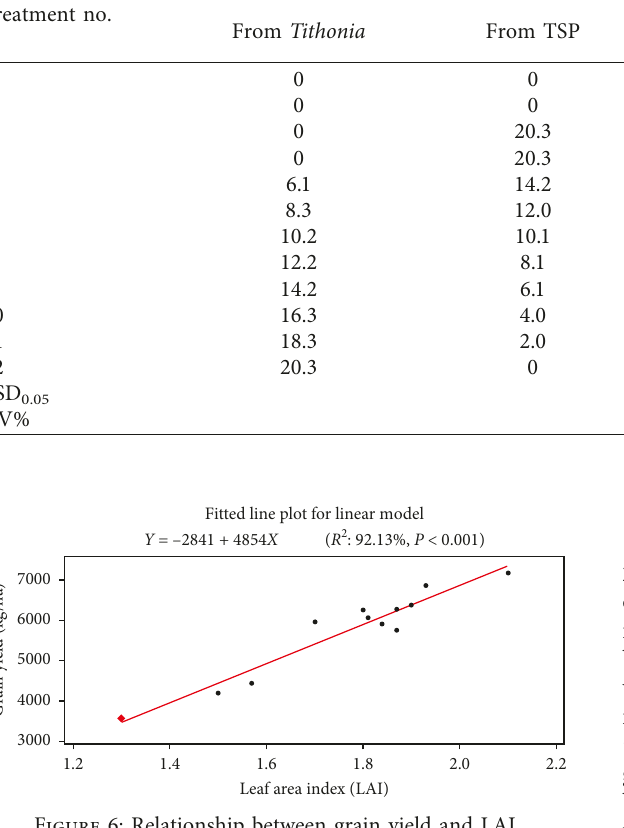
Table 6: Leaf area measurements of maize as affected by the combined application of Tithonia biomass and phosphorus fertilizer (TSP). Treatment no.